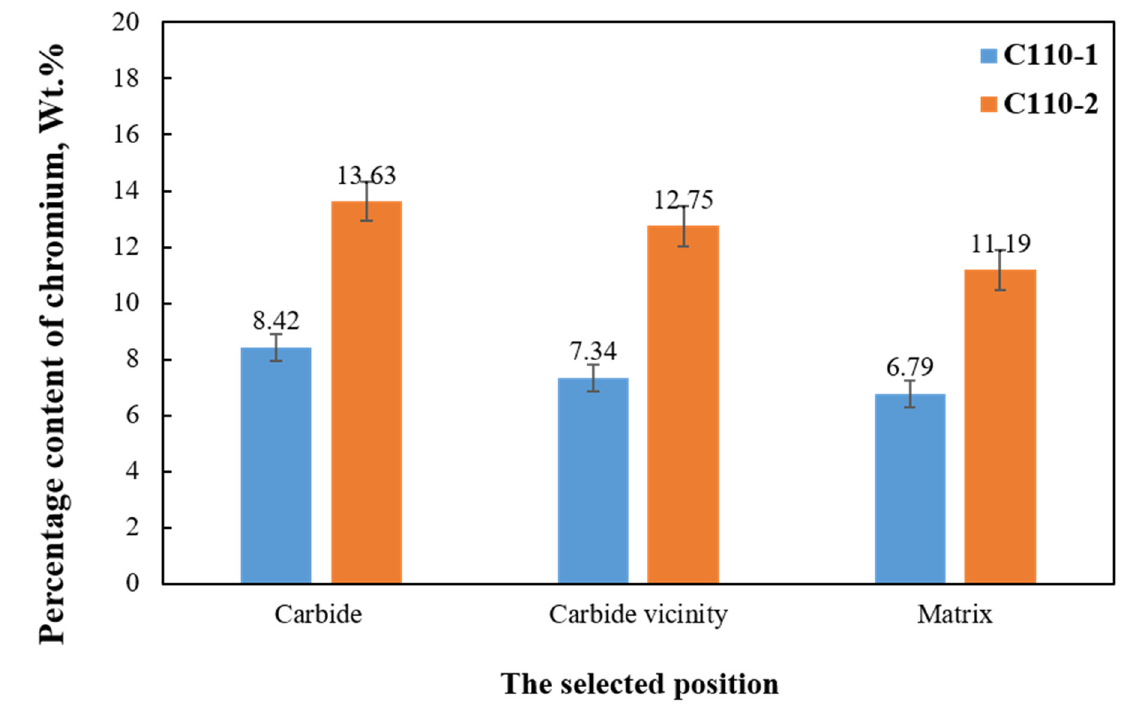
Figure 13. Comparison of Cr content.